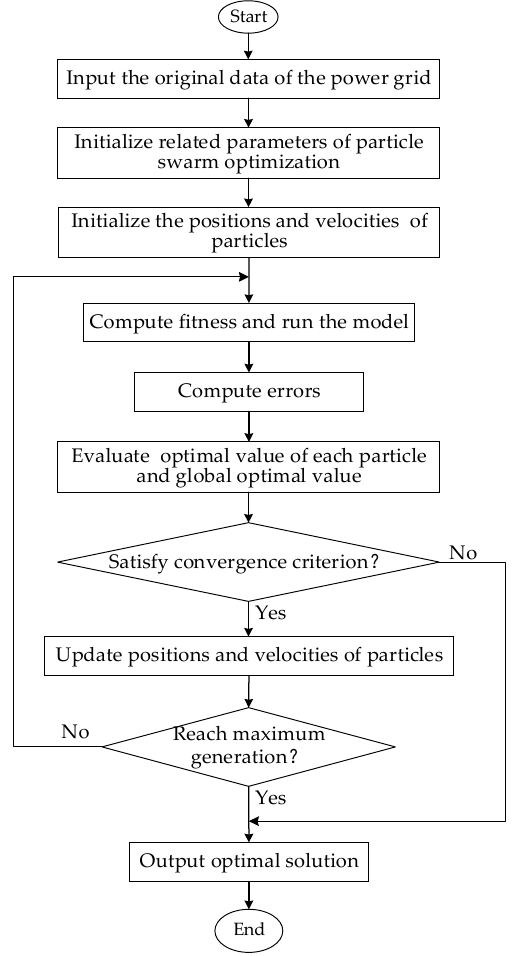
Figure 8. Flow chart of parameter identification.